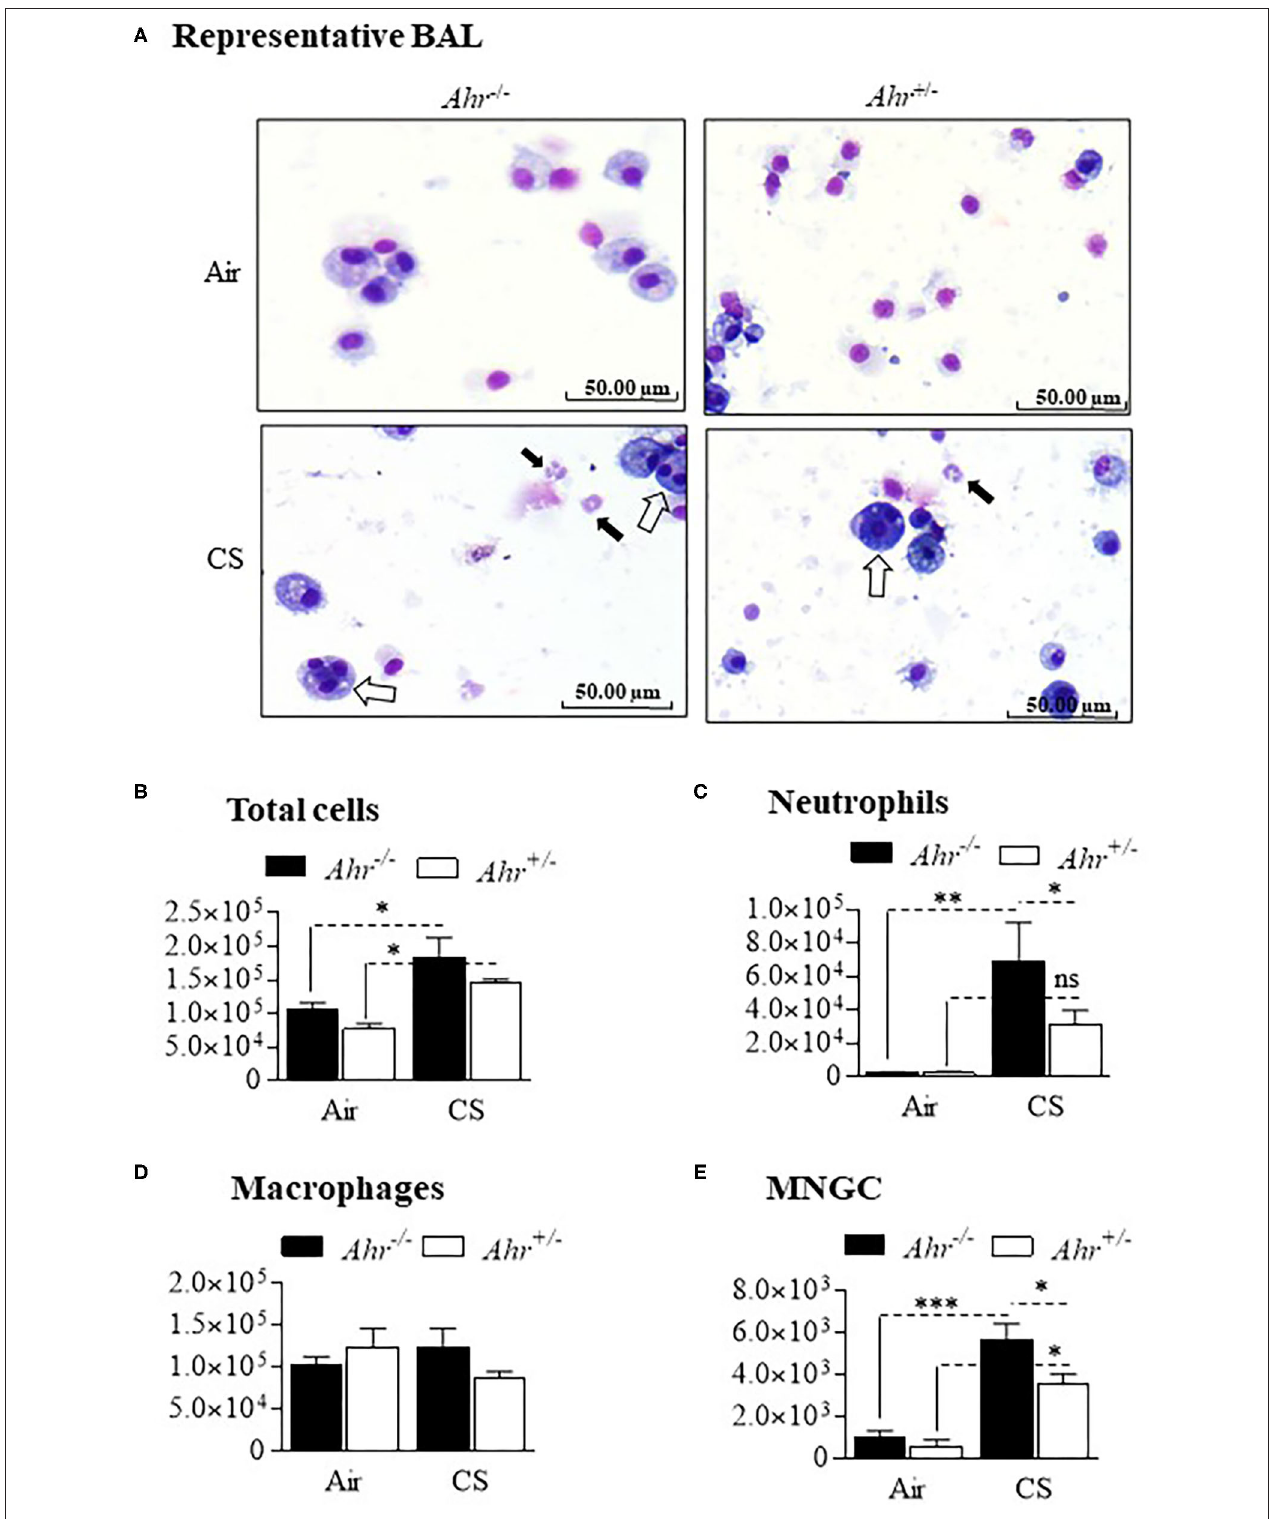
FIGURE 3 | Exposure to CS for 4 months causes heightened pulmonary inflammation characterized by the continued presence of MNGC. (A) BAL Cells- Representative images of cells from the BAL of Ahr + / − and Ahr − / − mice exposed to CS for 4 months. Note the presence of neutrophils ( black arrows )